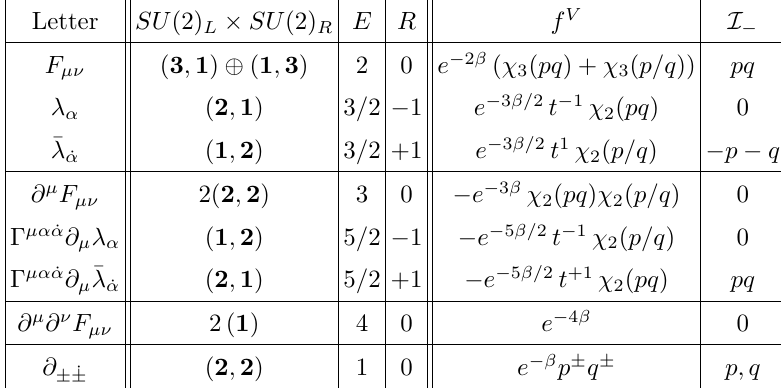
Table 1. Letter partition function of an N = 1 vector multiplet.